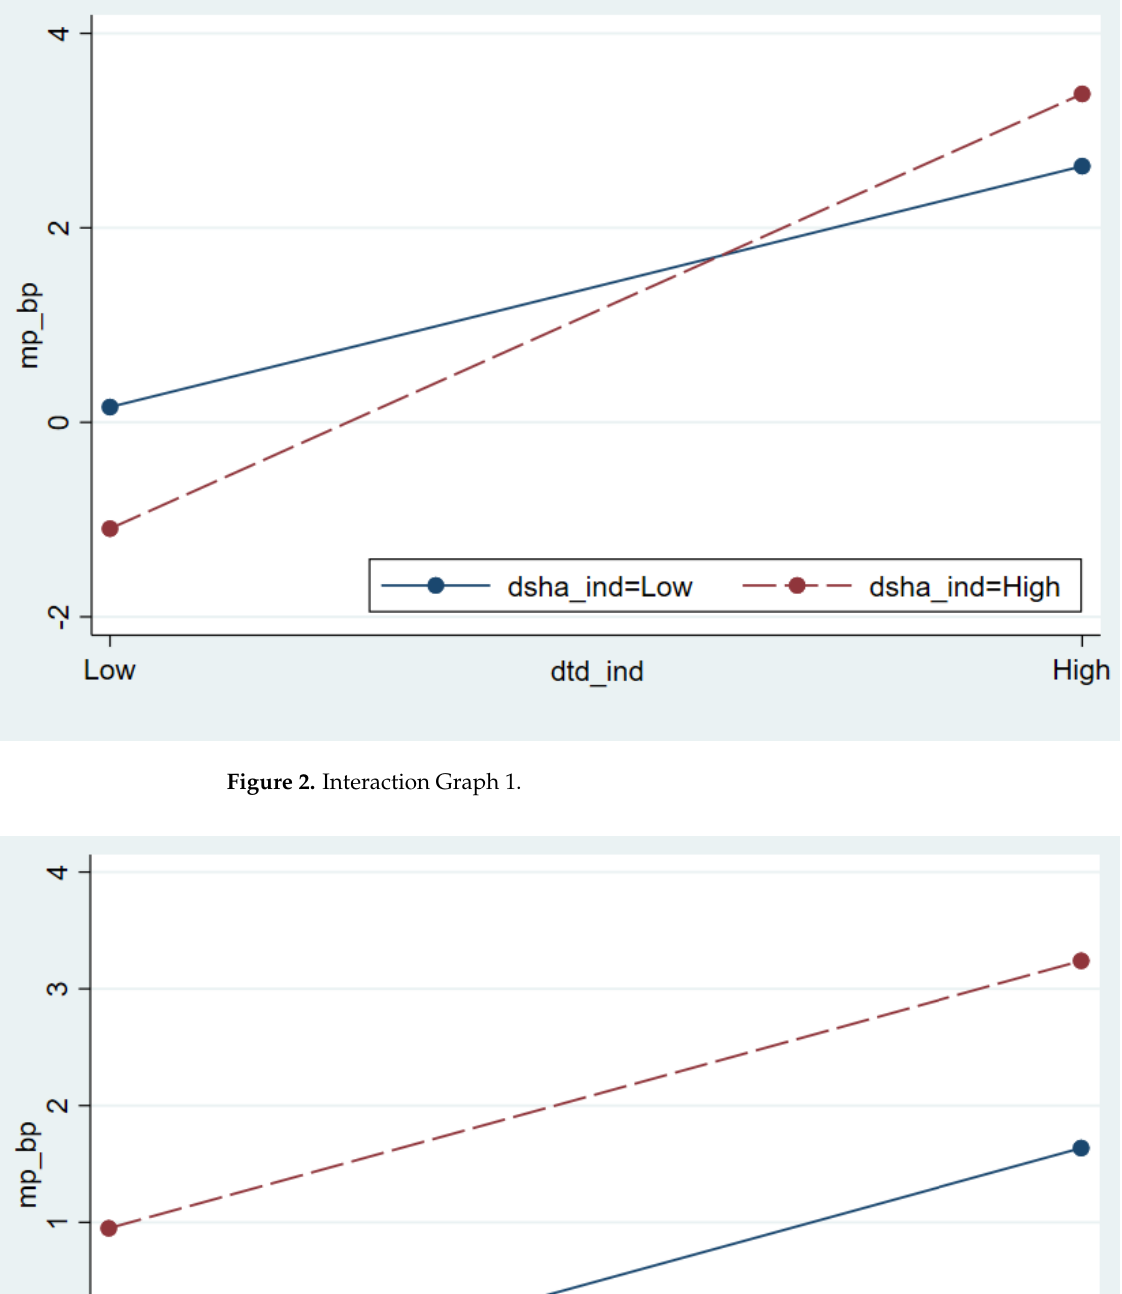
11 of 18 Table 5. Result (Static Model). DV: mp_bp